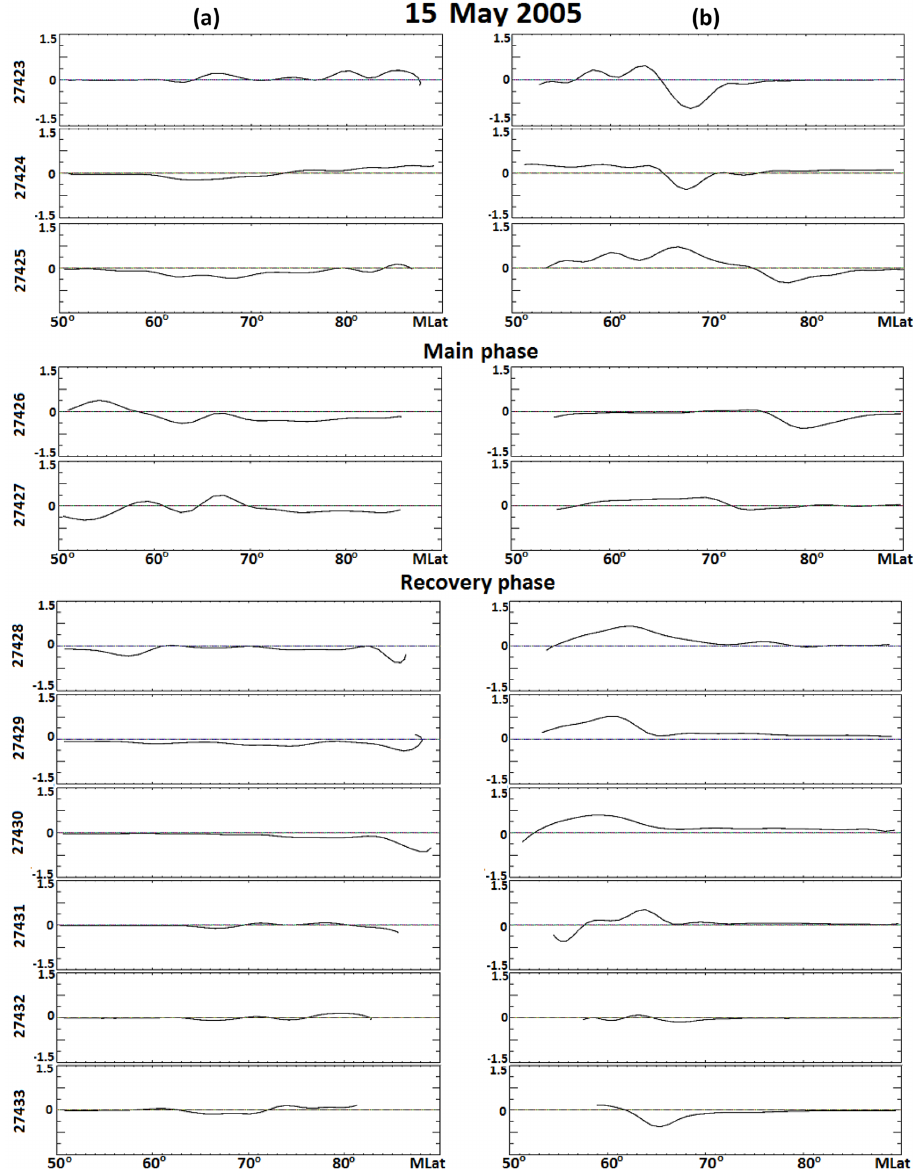
Figure A8. Direction and intensity values of the Hall current along the satellite orbit at the duskside ( a , 20:00–22:00MLT, corresponding to the ascending section of the orbit) and dawnside sectors ( b , 08:00–10:00MLT, descending orbit section). Positive currents denote an eastward current flow for the descending orbit section and a westward current for the ascending section,